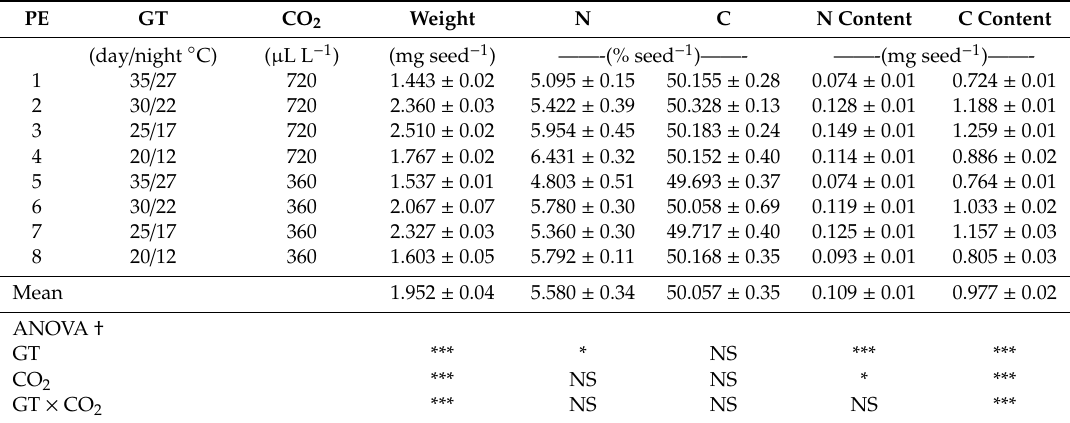
Table 1. Description of seed quality parameters, such as individual seed weight, nitrogen (N) and carbon percentages, and N and C content, obtained from plants harvested for each parental environment in the parental